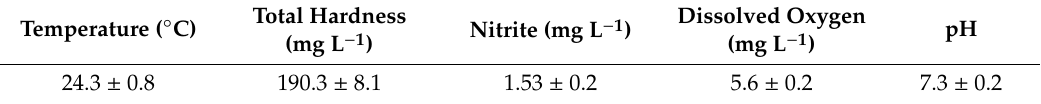
Table 1. Physical and chemical characteristics of water during the experimental period in this study.